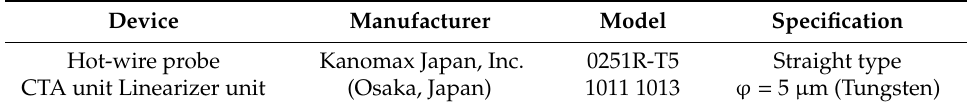
Table 3. Hot-wire anemometer